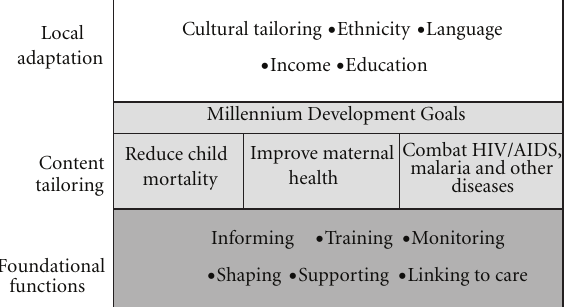
Figure 1: Framework for designing mHealth tools to achieve Millennium Development Goals for